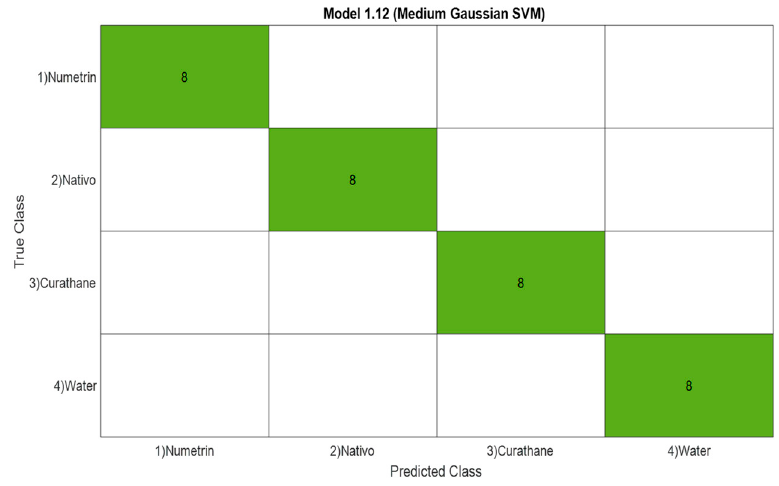
10 of 22 Figure 5. Confusion matrix obtained by applying the medium Gaussian–SVM model for classifying pesticides against distilled water samples.